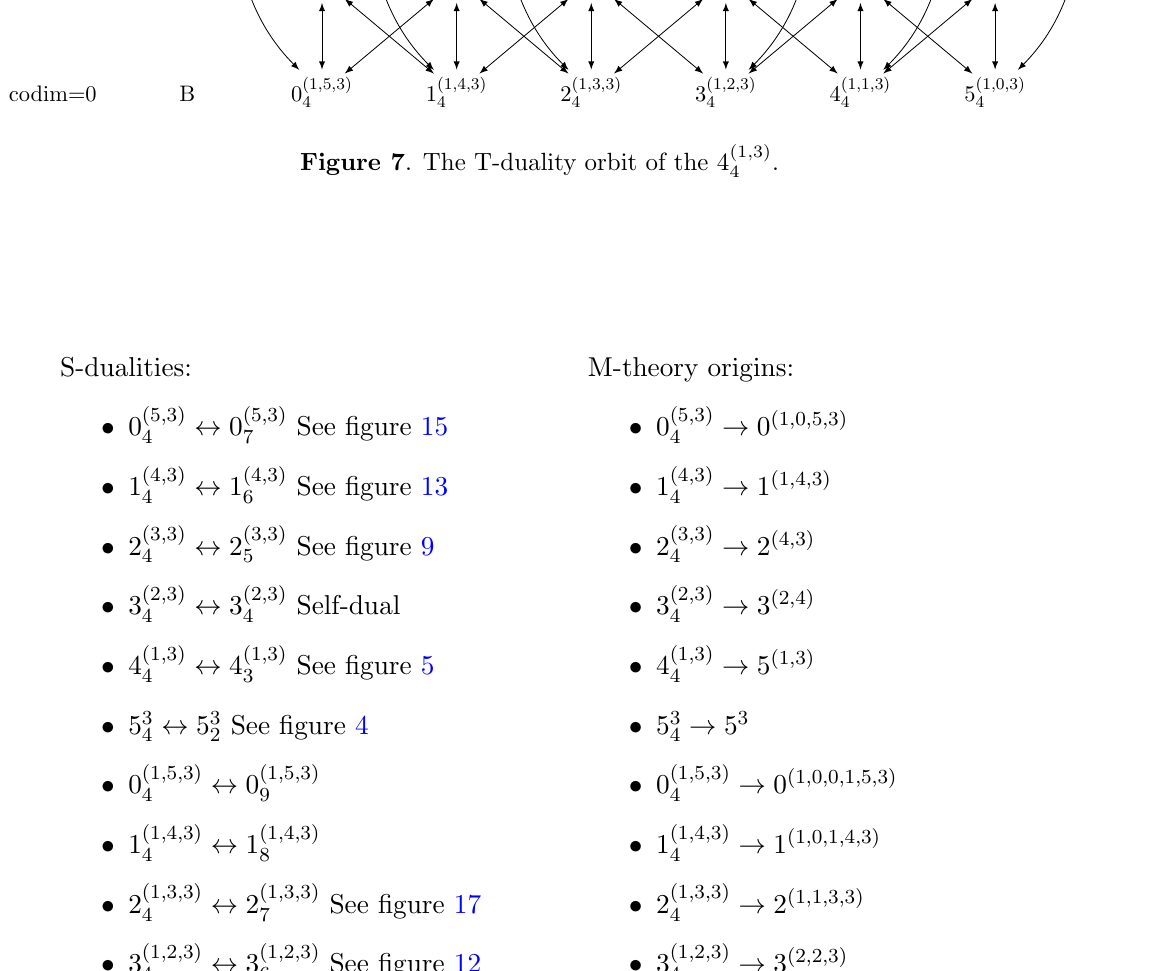
Figure 7 . The T-duality orbit of the 4 (1 ; 3)